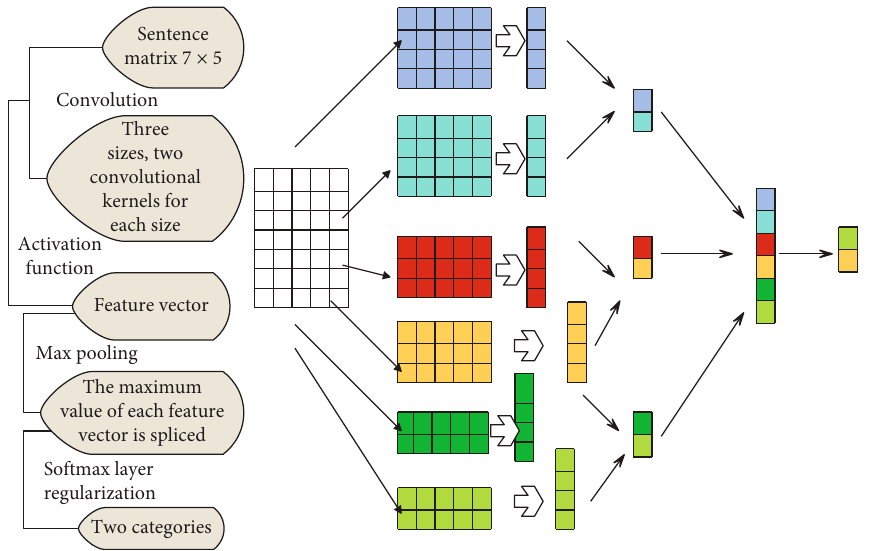
Figure 1: TextCNN model